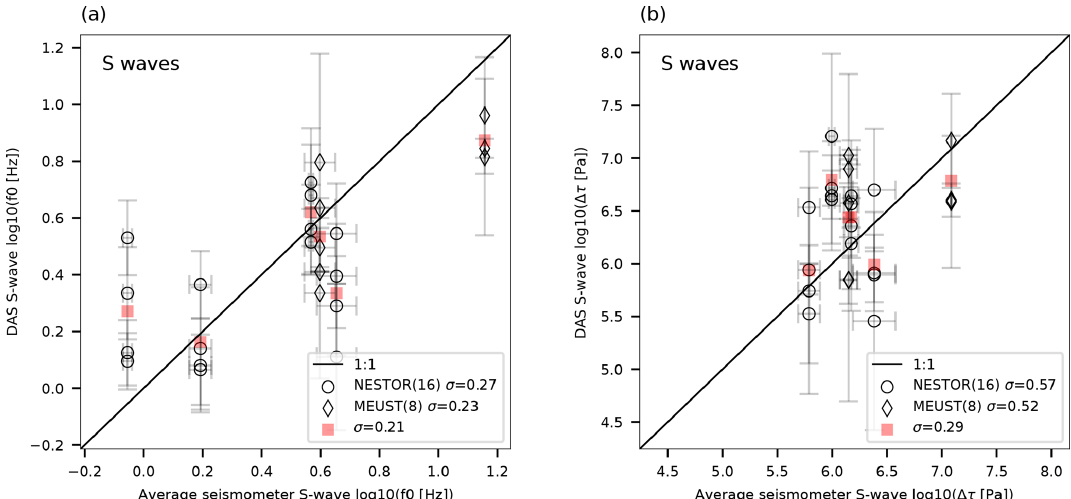
Figure 12. Comparison between DAS and seismometer source corner frequencies and stress drops. log (f 0 ) (a) and log ((cid:49)τ) (b) estimated using DAS recorded S waves are plotted as functions of average parameters obtained using seismometer records. DAS event averaged parameters are plotted in red squares. The black curve is a 1 : 1 line. The number of data points and standard deviations to parameter residuals are indicated in the legends. DAS parameter errors are the standard deviations for parameters determined for each individual seismogram in the analyzed fiber segment, while seismometer errors are the standard deviations for single seismometer